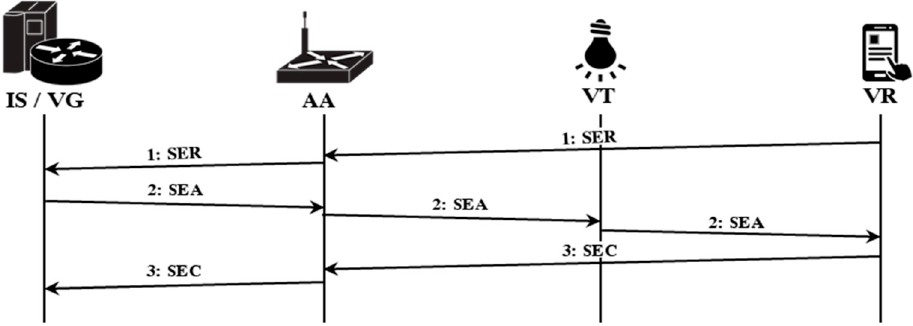
Figure 9. Session establishment operations.